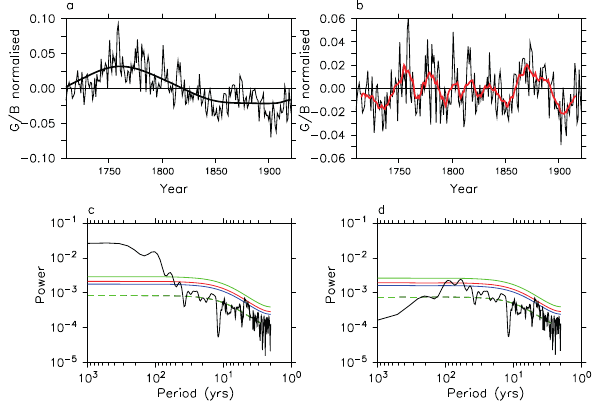
Fig. 2. Time series of annual mean G/B anomalies of the MASB data (a) for 1709–1920 (thin line). The thick curve represents the reconstructed long-term variation of MASB from the first two SSA (Singular Spectrum Analysis) modes that represent 55% of the to- tal MASB variability. Time series of the MASB data (b) in which the long-term variation in (a) is subtracted. An 11yr running av- erage (red) is applied to the time series in order to visualise the interdecadal and multidecadal changes. The spectrum of (a) and (b) are shown in (c) and (d) , respectively. Confidence levels are indi- cated with green (99%), red (95%), blue (90%) and green dashed (median) lines,